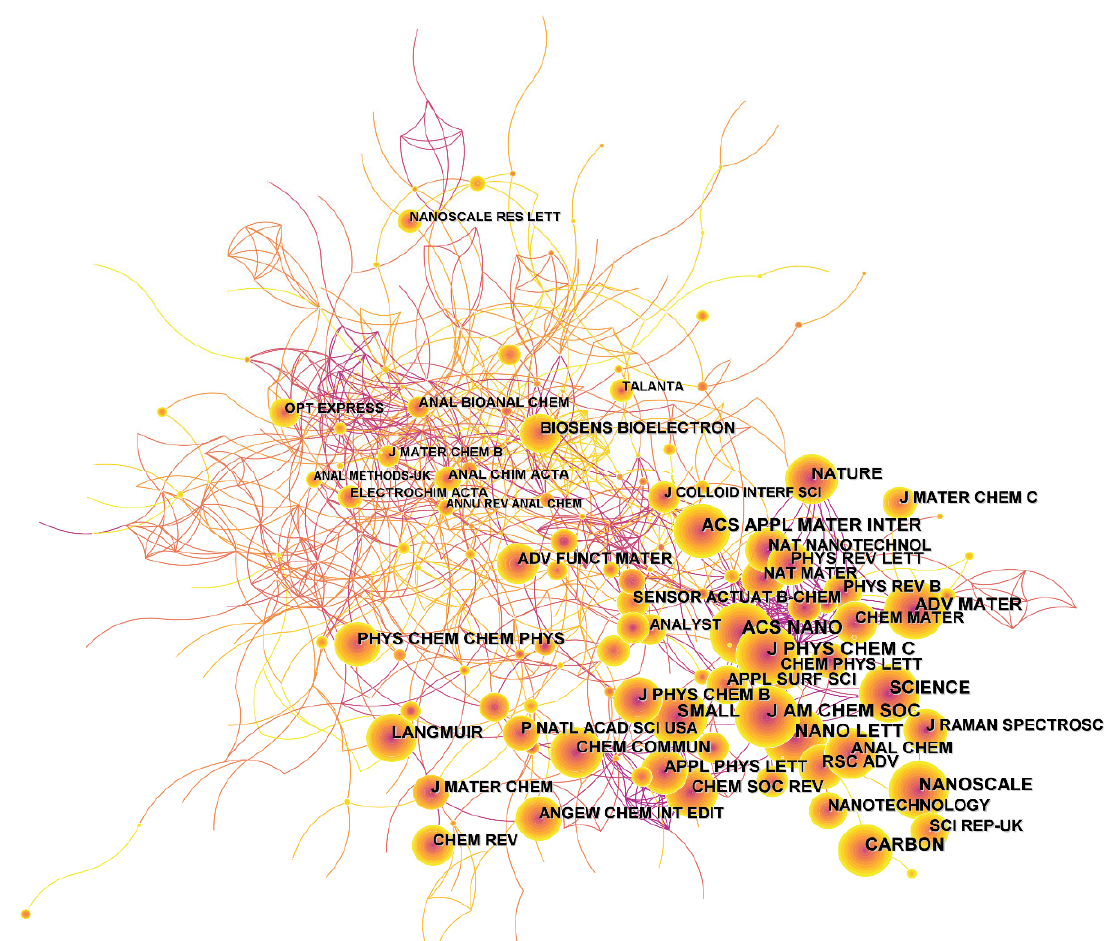
Figure 3. The co ‐ occurrence network of cited journals for graphene ‐ based SERS. Figure 3. The co-occurrence network of cited journals for graphene-based